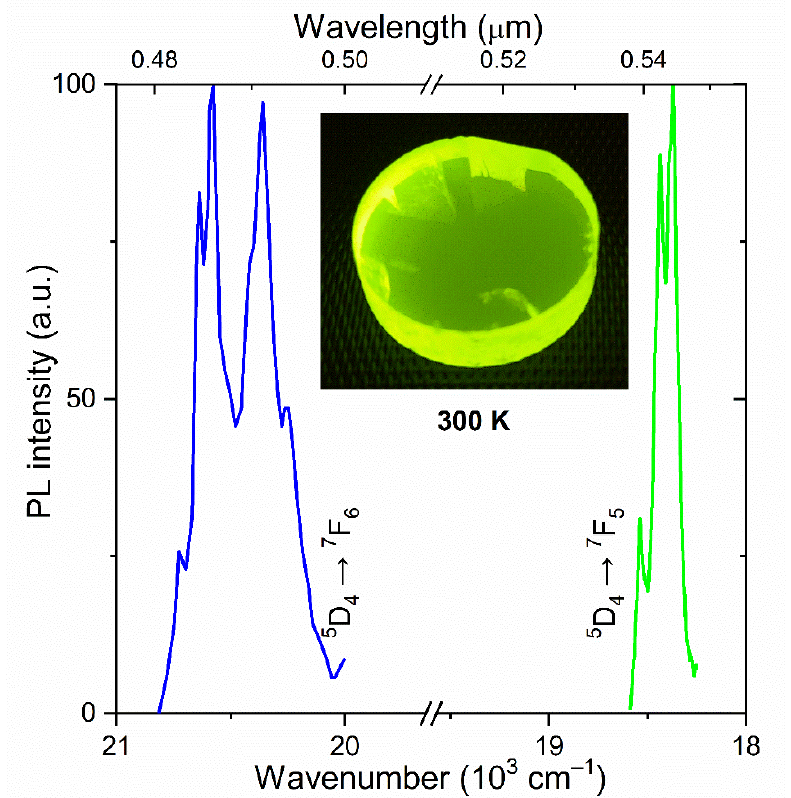
Figure 3. The normalized PL spectra of a KTF crystal at RT. Insert: the visible PL of the investigated crystals under UV excitation.